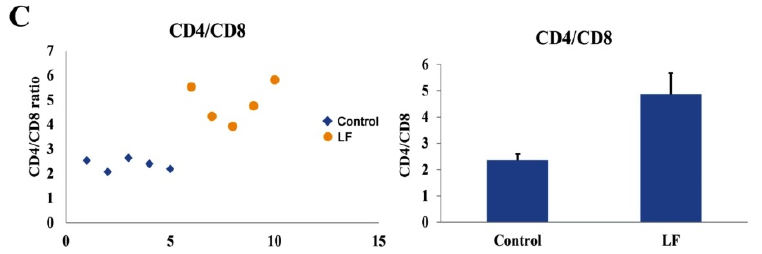
Figure 4. Effects of Apo–LF on immunocytes in blood of mice. ( A ) Representative flow cytometry analysis plot for blood CD4 + and CD8 + T cells in the mice from the control group; ( B ) Representative flow cytometry analysis plot for blood CD4 + and CD8 + T cells in the mice treated with lactoferrin (250 mg·kg − 1 b.w.); ( C ) The difference in the ratio of blood CD4 + /CD8 + T cells between the mice treated with saline and Apo–LF. n = 5 mice per group.